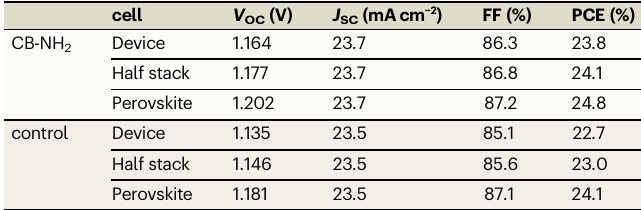
Table 2 | Parameters of pseudo JV curves constructed